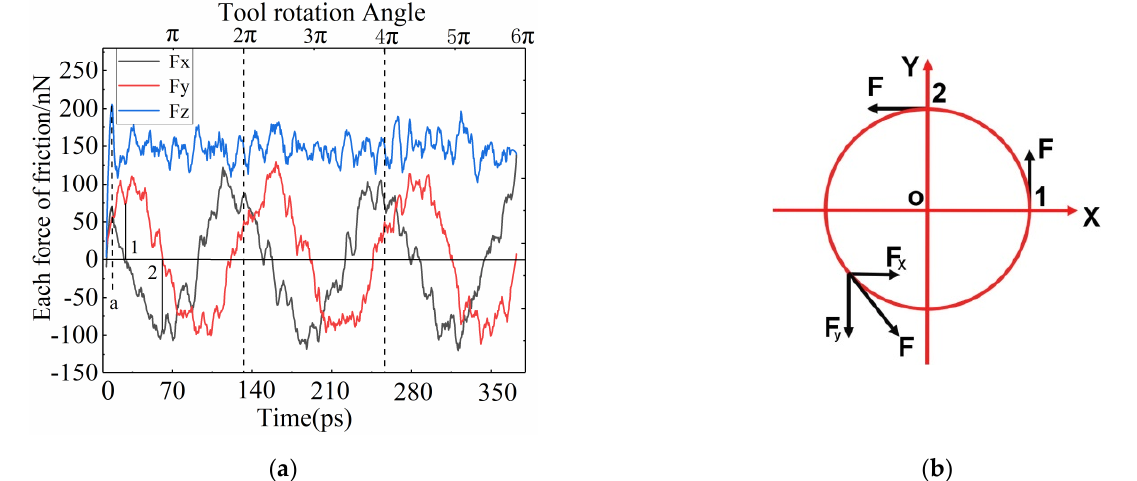
Figure 3. Diagrams of each component and rotation diagram: ( a ) is variation of force component curve in the three directions and ( b ) is total friction and friction component .